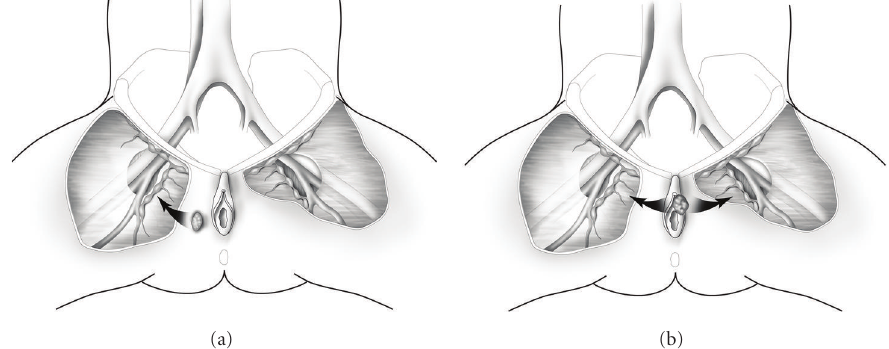
Figure 1: Lateral vulvar lesions > 1cm from the midline (a) spread initially to the ipsilateral superficial inguinal lymph nodes, whereas midline lesions can spread to both groins (b).